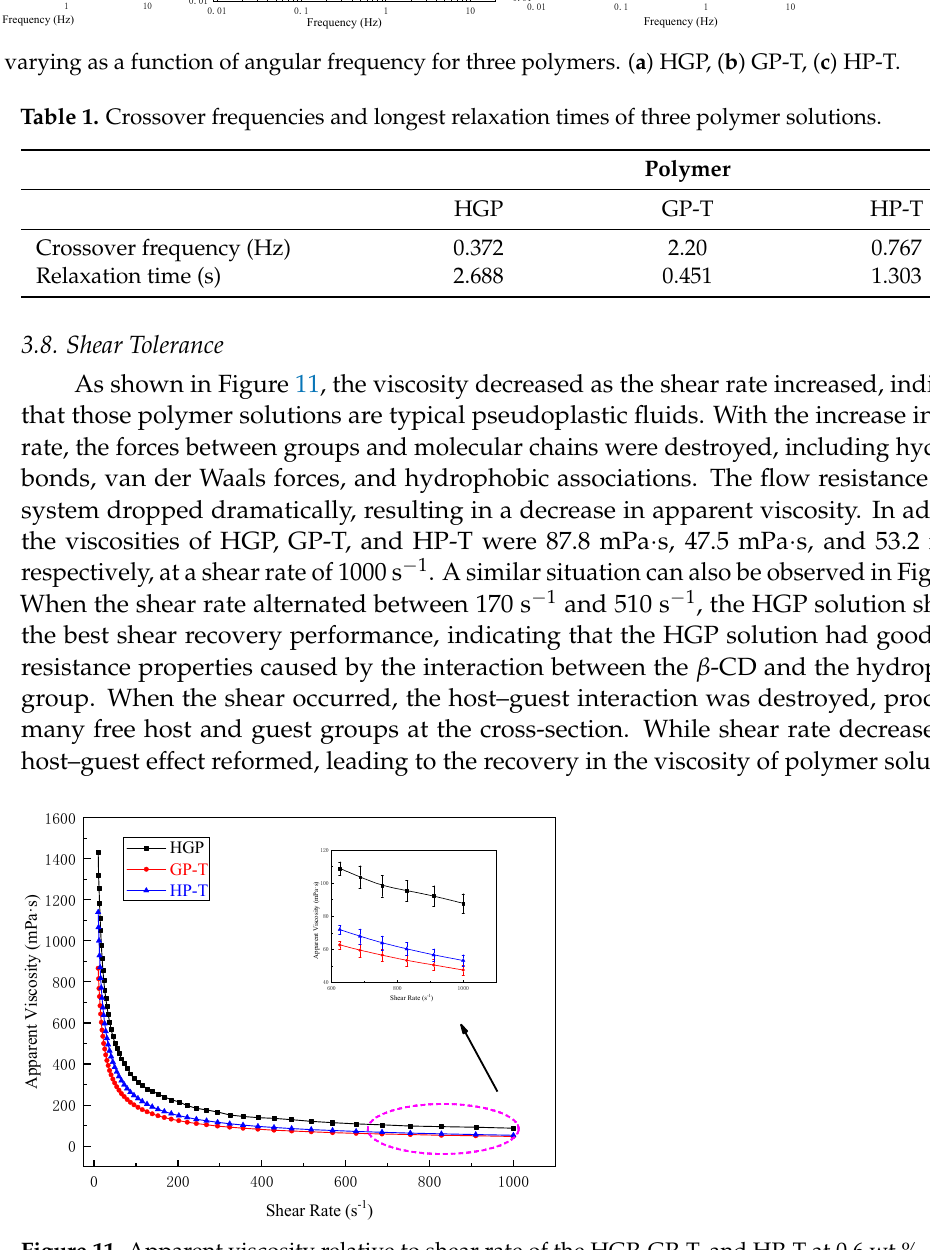
Table 1. Crossover frequencies and longest relaxation times of three polymer solutions.